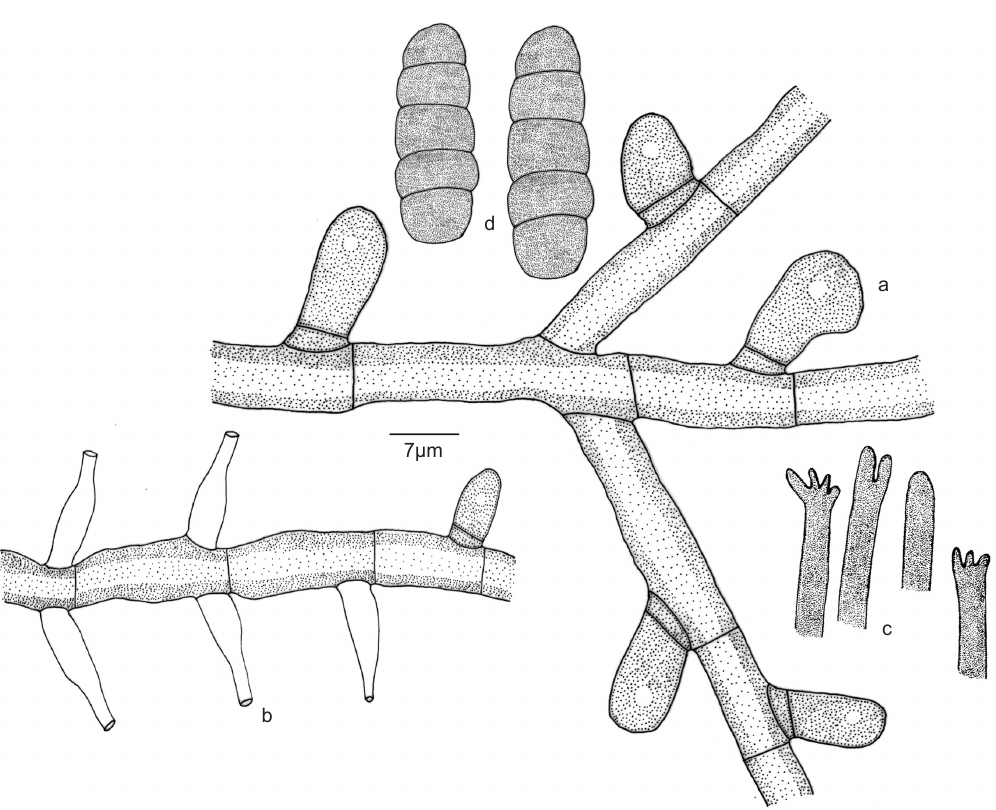
Figure 5. Meliola garugae Stev. & Rold. a - Appressorium; b - Phialide; c - Apical portion of the mycelial setae; d -